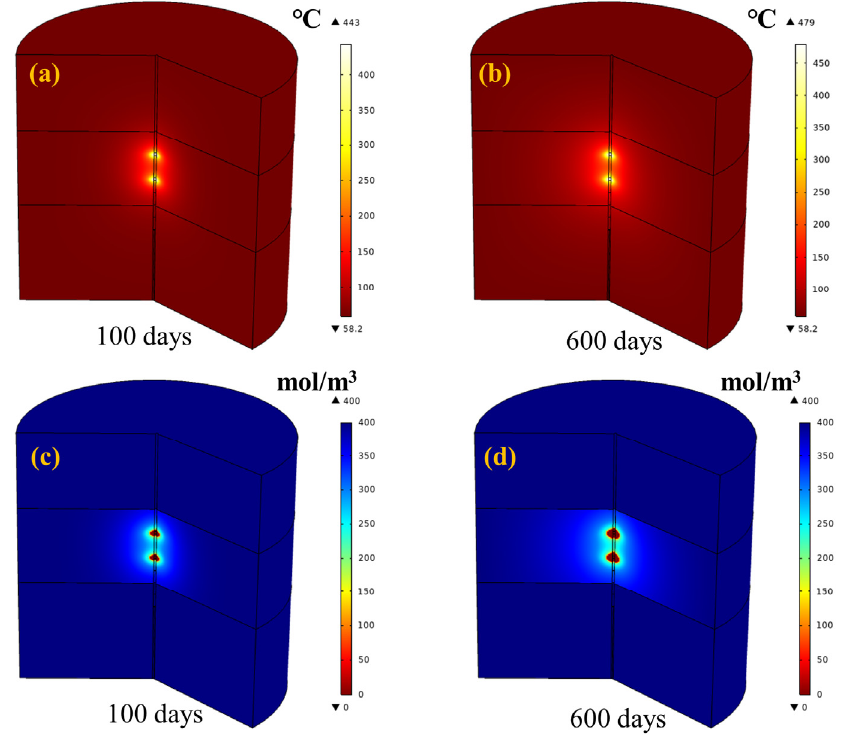
Figure 8. The effect of antennas number on the temperature distribution and kerogen decomposition: ( a ) reservoir temperature at 100 days, ( b ) reservoir temperature at 600 days, ( c ) kerogen concentration at 100 days, and ( d ) kerogen concentration at 600 days.